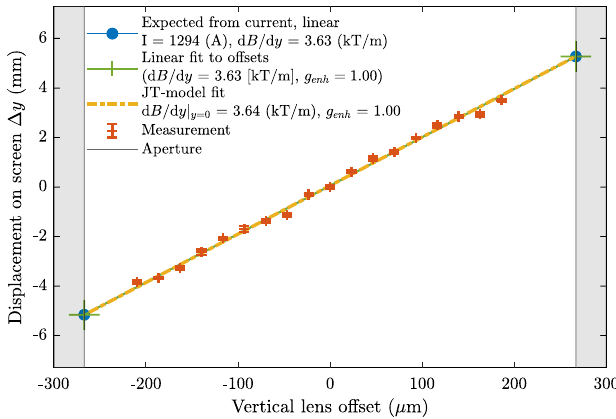
FIG. 6. Beam displacement as a function of lens offset in argon on peak current, for measuring the field gradient.